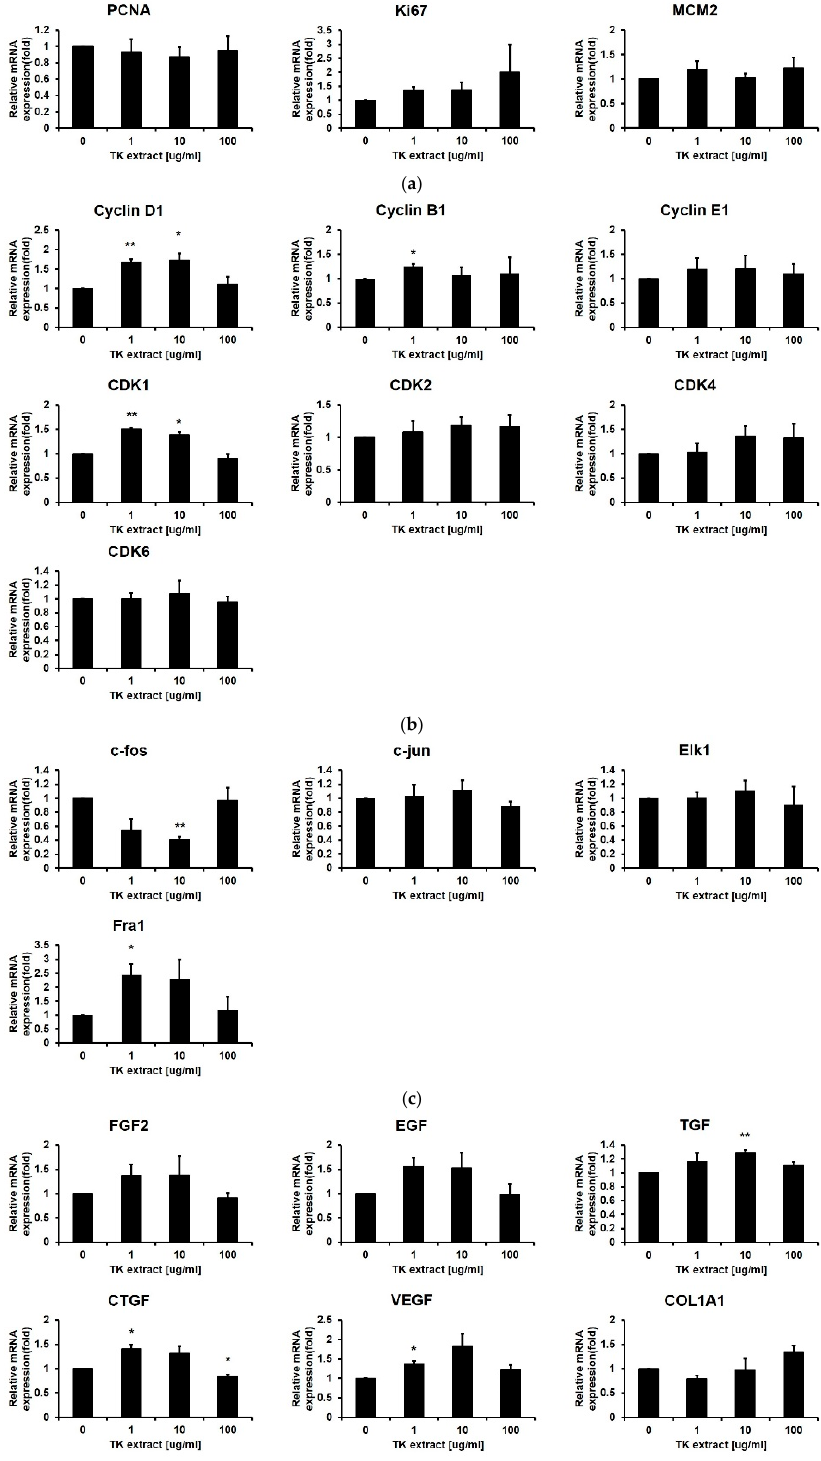
was also tested by qRT-PCR . The mRNA expression change of the Hs68 cells was not significant, except for Cyclin D1 (172.9% at 10 μ g/mL), CDK1 (150.8% at 1 μ g/mL), EGF (155.4% at 1 μ g/mL), and VEGF (181.9% at 10 μ g/mL) (Figure 6). Taken together, in fibro- blasts, proliferation was not promoted as in keratinocytes, and significant changes in gene expression were not observed. The efficacy of TK extract on fibroblasts appears to be minor.